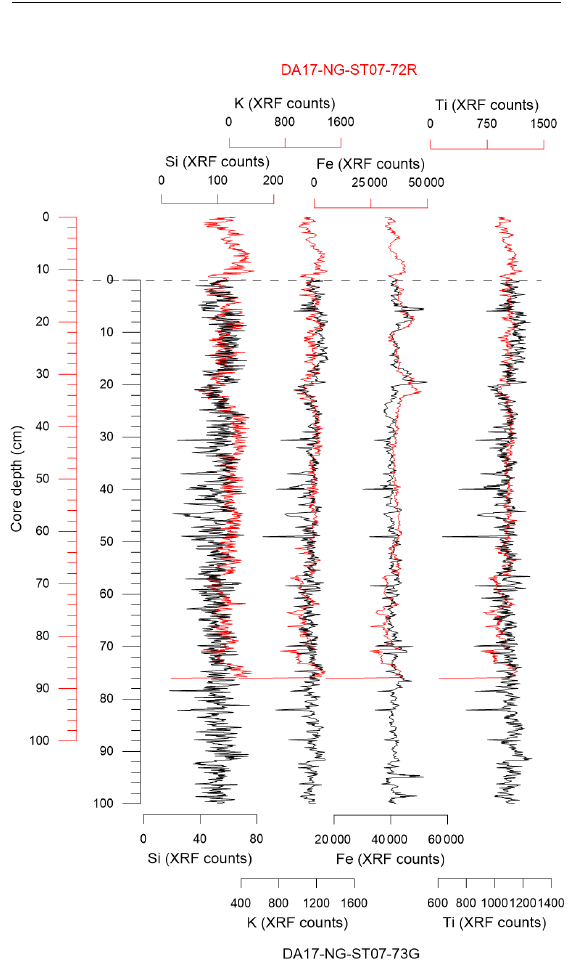
Figure A1. Comparison of XRF data from gravity core DA17-NG-ST07-73G (black) and Rumohr core DA17-NG-ST07-72R (red).